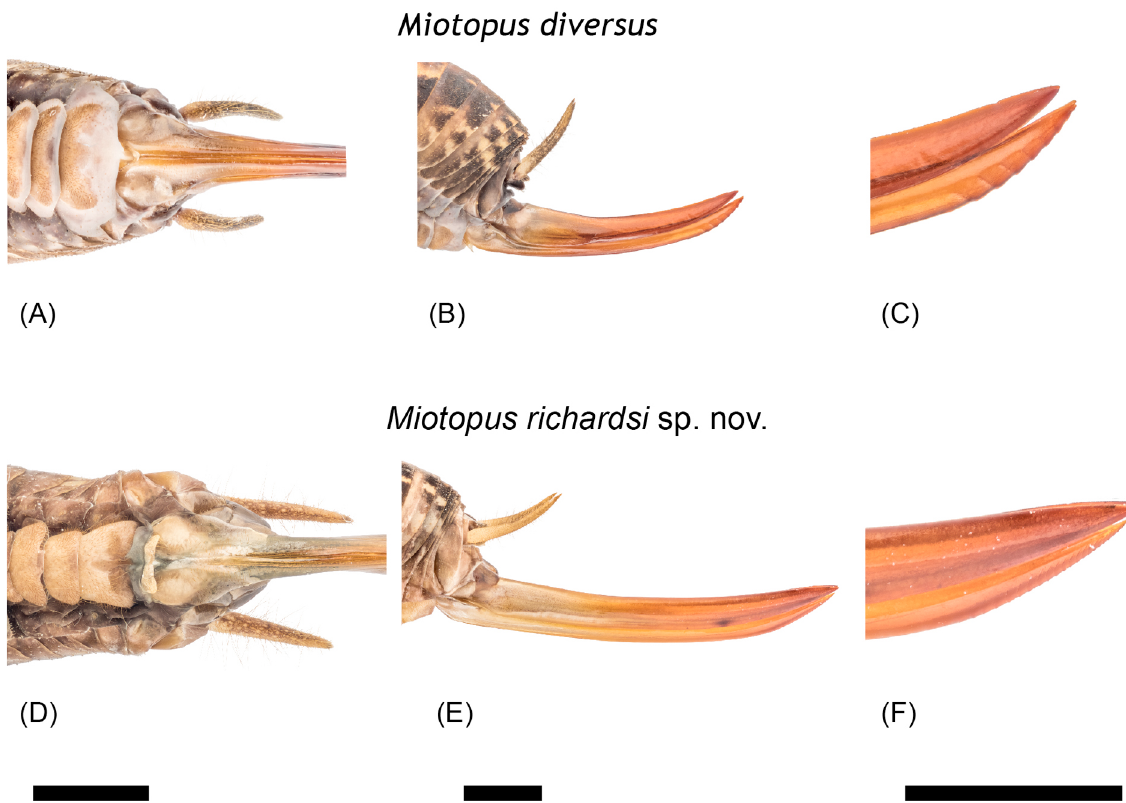
Fig. 8. Female terminalia of Miotopus Hutton, 1898 cave wētā. A–C . Miotopus diversus (hutton, 1896) (MPN Cw3596). A . Ventral. B–C . Lateral views. D–F . Miotopus richardsi sp. nov. (MPN Cw3543). D . Ventral. E–F . lateral views. Scale bars = 3